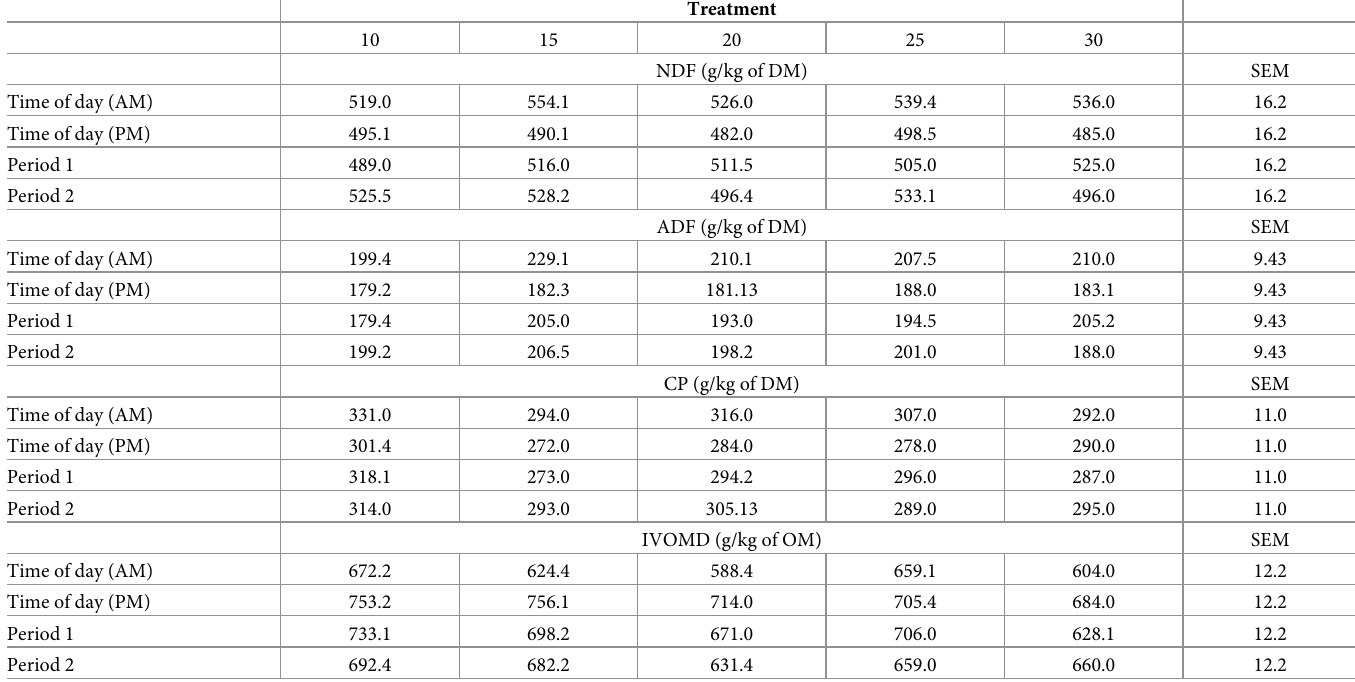
Table 2. Nutritional value of hand-plucked herbage samples of five sward heights of Kikuyu grass ( Cenchrus clandestinus— Hochst. ex Chiov) at two times of day in two periods of evaluation.